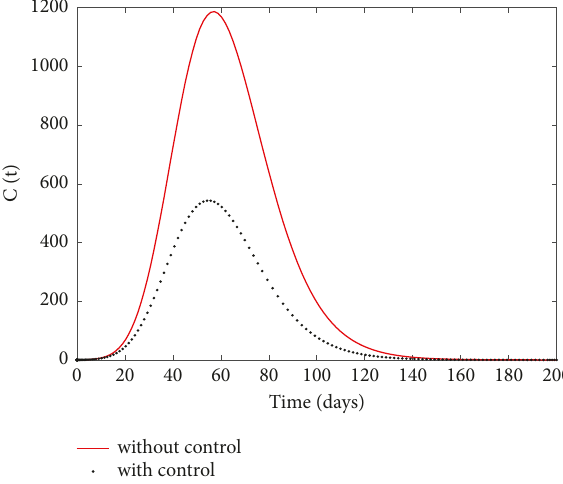
Figure 14: Behaviour of COVID-19 patients with diabetes with and without lockdown